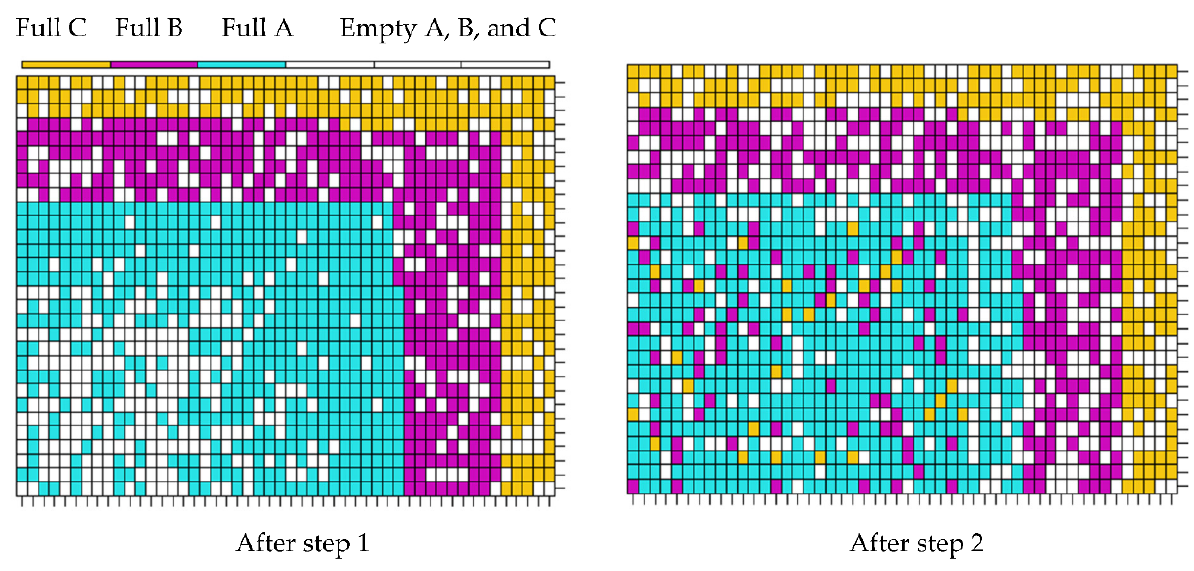
Figure 8. Positions of loads in the rack after step 1 and step 2 with ABC allocation. Table 3. The results for the two preparation